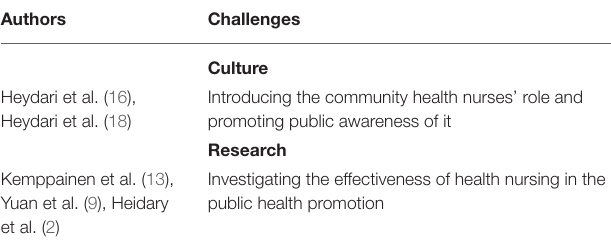
TABLE 3 | The challenges of community health nursing and the identified